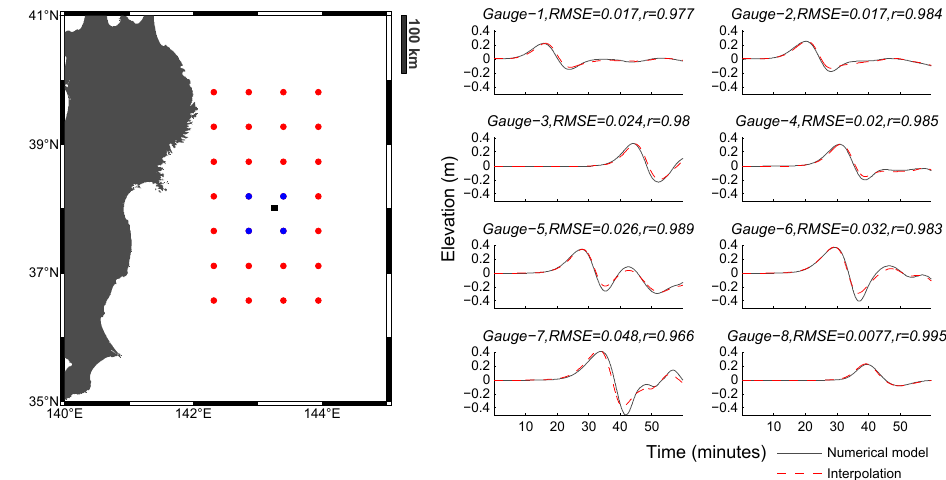
Figure 4. Waveform interpolation. Left-hand figure shows selected location of a unit source indicated by a black square. Blue dots represent the four nearest unit sources used in the interpolation. Right-hand figures are comparisons of waveforms between numerical model (solid black line) and interpolation (dashed red line) at the artificial gauges.